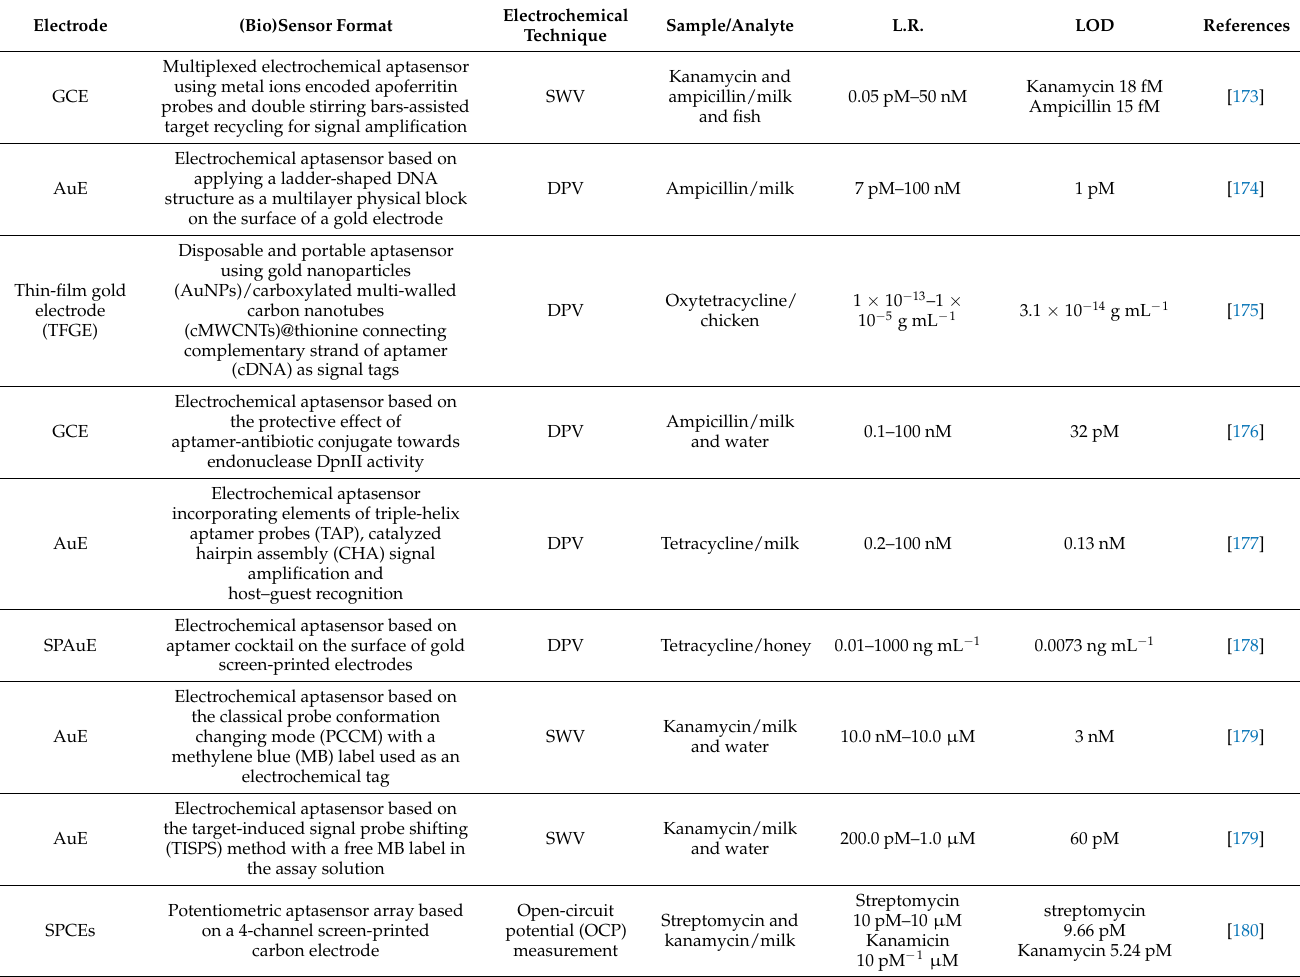
Table 4. An overview of recent electrochemical biosensors for antibiotics